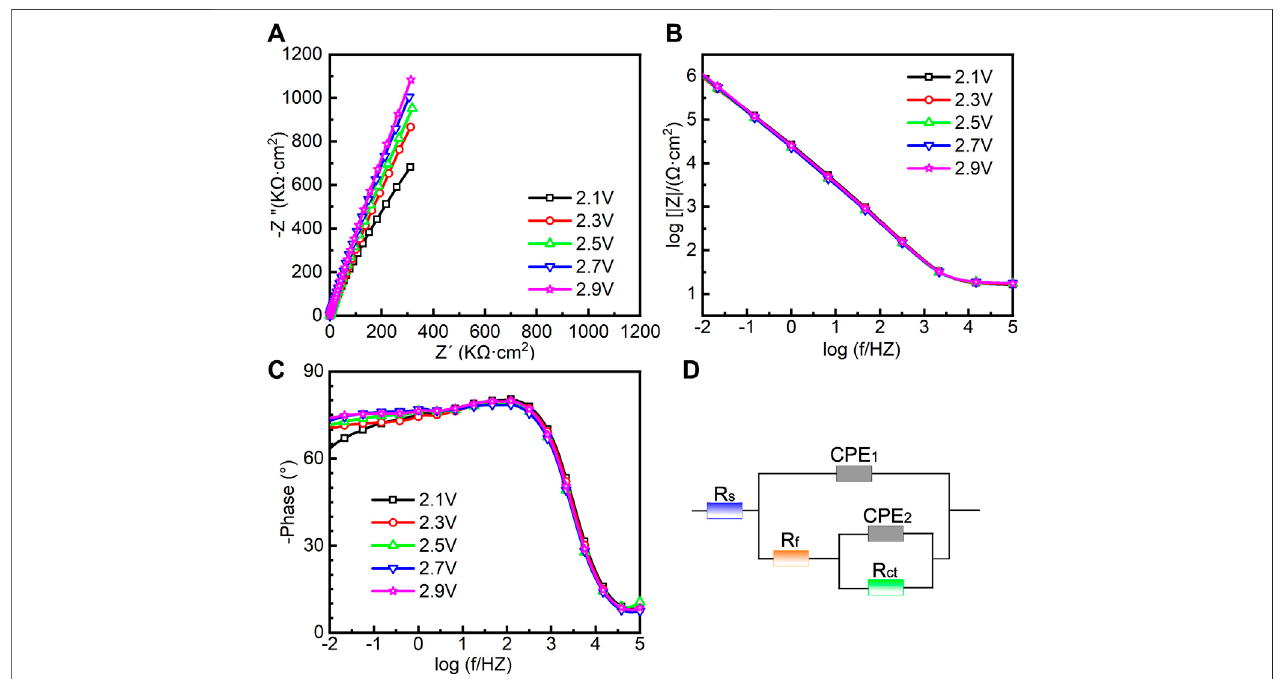
FIGURE 7 | Electrochemicalimpedance spectroscopy of as-cast Ti-6Al-4Vunder different fi lm formation potentials in the repassivation range in Hank ’ s solution at 37 ° C, (A) Nyquist plots, (B) Bode impedance plots, (C) Bode phase diagram and (D) equivalent circuit.